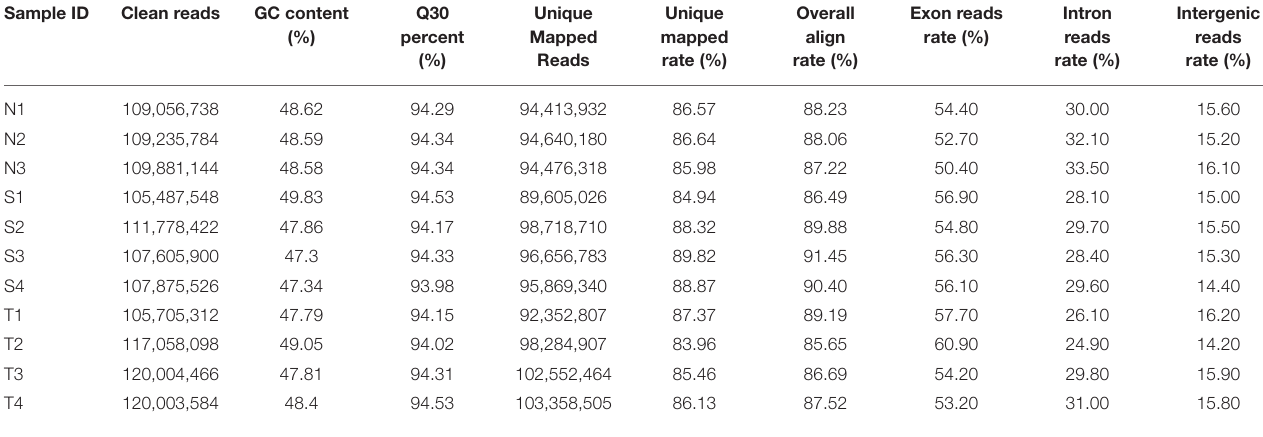
TABLE 2 | The statistics of sequencing data and mapping